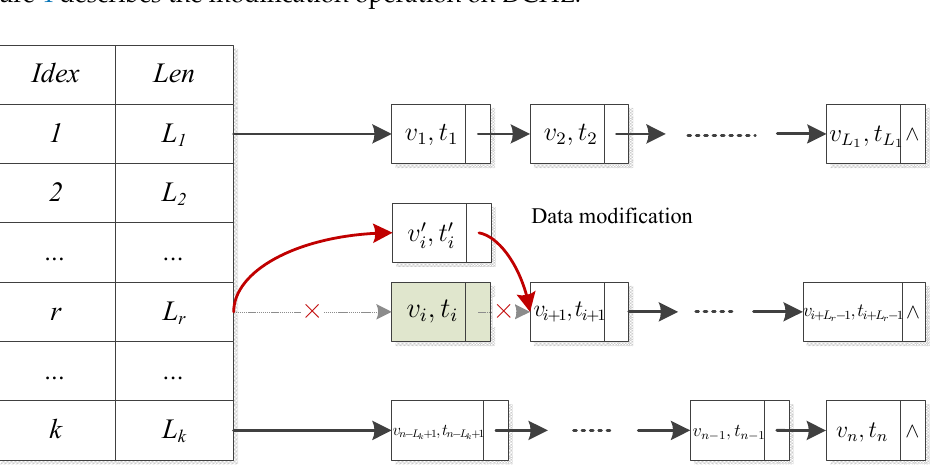
Figure 4. Data block modification